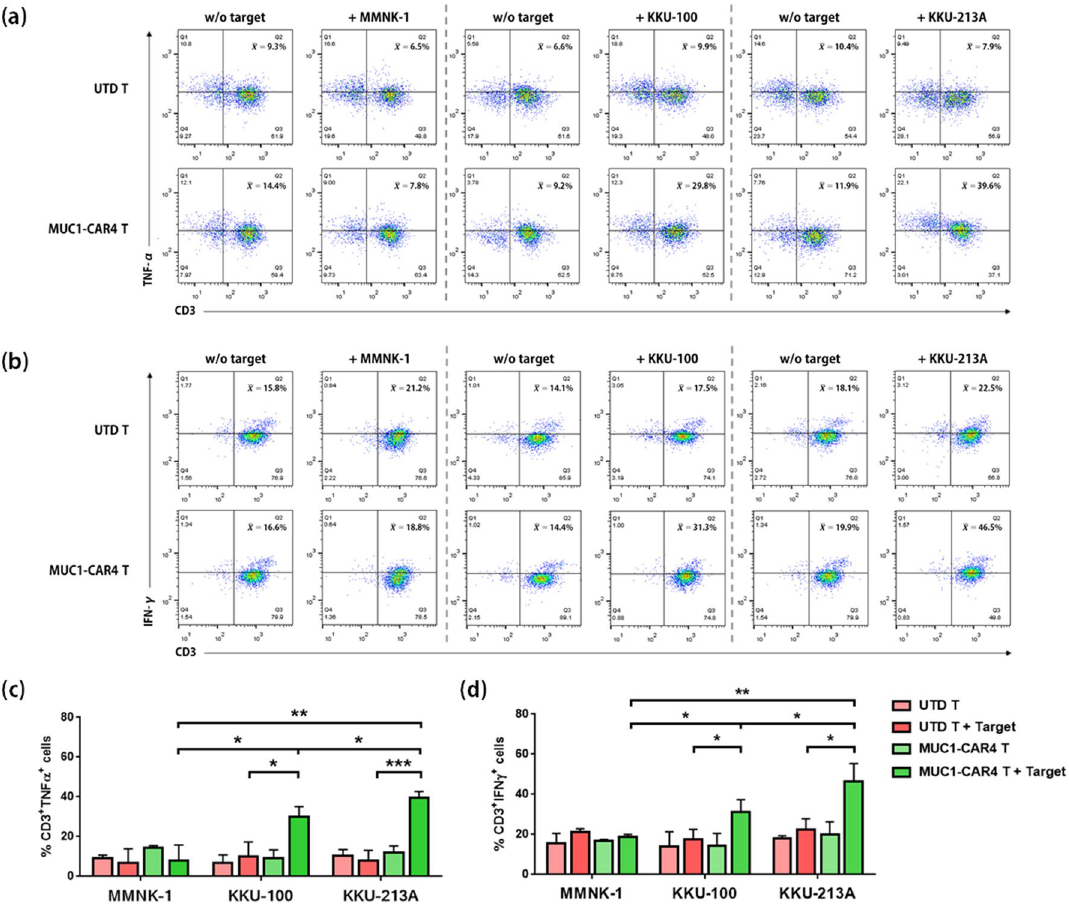
Figure 5. TNF-α and IFN-γ production by anti-MUC1-CAR4 T cells following exposure to CCA cells. The representative cell gating data of ( a ) TNF-α and ( b ) IFN-γ cytokine production in untransduced (UTD) T cells, UTD T cells plus target cells, anti-MUC1-CAR4 T cells alone, and anti-MUC1-CAR4 T cells co-cultured with MMNK-1, KKU100, and KKU-213A. The percentages of TNF-α ( c ) and IFN-γ ( d ) producing cells plotted as bar graphs were individually averaged from 3 independent experiments (mean ± SD). All data were analyzed by Student t -test (asterisks represent p -values: * p < 0.05, ** p < 0.01, *** p < 100 (31.33 ± 6.02%, p -value 0.0123) and KKU-213A cells (46.5 ± 8.822%, p -value 0.0157), compared to UTD T cells (Fig. 5b,d). The significantly higher IFN-γ production in the anti-MUC1-CAR4 T cells exposed to KKU- 213A was found when compared with the anti-MUC1-CAR4 T cells exposed to KKU-100 ( p -value 0.0412). Both TNF-α and IFN-γ cytokines were produced at lower levels when anti-MUC1-CAR4 T cells were exposed to MMNK-1 cells (7.75 ± 8.05% and 18.8 ± 1.21%, respectively), which were not significant difference from those of UTD T cells (9.3 ± 1.43% and 21.2 ± 1.69%, respectively) (Fig. 5). In addition, the significantly higher produc- tion of TNF-α and IFN-γ were found in CD8 + fraction of the anti-MUC1-CAR4 T cells after co-culture with MUC1-expressing cancer cells (Supplement Fig. 5a,b). In summary, the levels of TNF-α and IFN-γ produced by anti-MUC1-CAR4 T cells were related to MUC1 expression on the cancer cell membrane. Cytotoxic function of anti‑MUC1‑CAR4 T cells on MUC1‑expressing CCA cells. To examine the cytotoxic function of anti-MUC1-CAR4 T cells, the CAR4 T cells were co-cultured with MMNK-1, KKU-100, and KKU-213A cells, which showed different cell surface expression of MUC1: 4.02 ± 0.994%, 15.14 ± 1.526%, and 58.8 ± 12.59%, respectively (Fig. 2d,e). These non-transformed cholangiocytes (MMNK-1) and CCA cancer cells (KKU-100 and KKU-213A) were genetically engineered to express green fluorescent protein and luciferase. The anti-MUC1-CAR4 T cells were co-cultured with these target cells at E:T ratios of 1:1, 2.5:1, and 5:1 for 18 h. After exposure to the anti-MUC1-CAR4 T cells, KKU-100 and KKU-213A cells were lysed in a dose-dependent manner, but MMNK-1 cells showed low cytolysis (Fig. 6a). The cytotoxic functions of anti-MUC1-CAR4 T cells on MMNK-1, KKU-100, and KKU-213A cells were also examined by luciferase assay. Compared to UTD T cells, the anti-MUC1-CAR4 T cells showed a cytotoxic effect on KKU-100 and KKU-213A, but not on MMNK-1 cells. The cytotoxic effects of the anti-MUC1-CAR4 T cells on KKU-100 and KKU-213A cells at an E:T ratio of 1:1 were 34.82 ± 13.18% ( p -value 0.0078) and 34.34 ± 14.62% ( p -value 0.0213), respectively. At E:T ratios of 2.5:1 and 5:1, the percentages of KKU-100 lysis were slightly